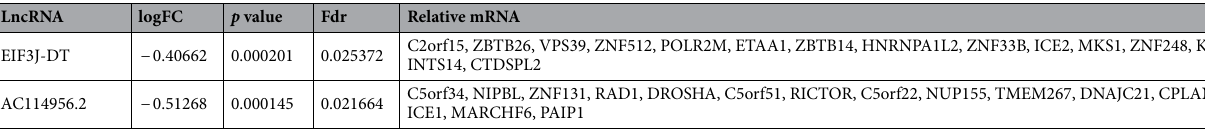
Table 2. Differentially expressed lncRNAs and relative mRNAs.